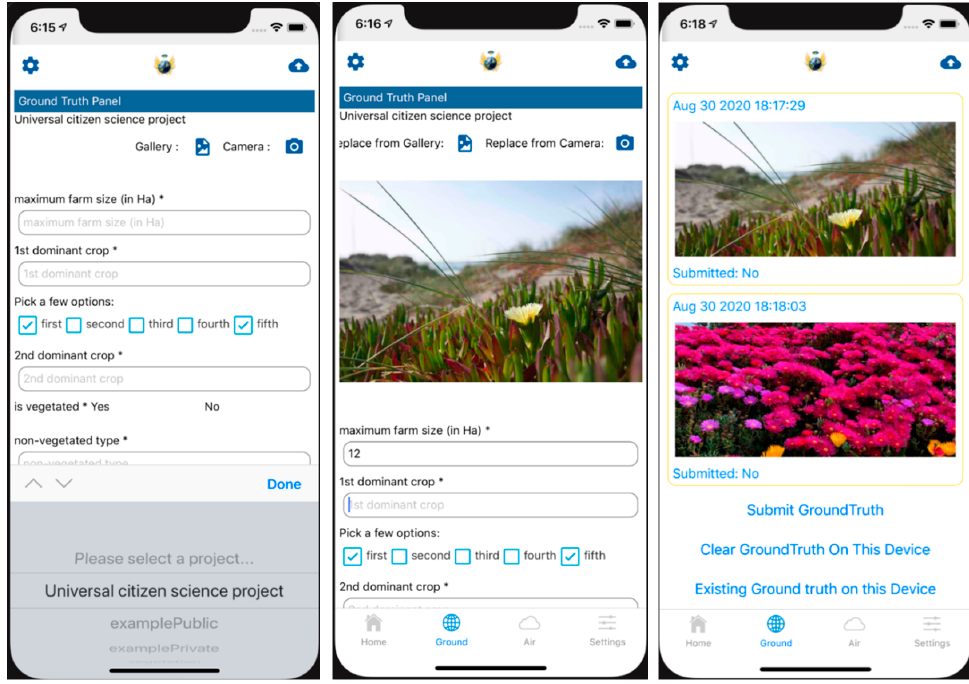
Figure 6. Flexible Citizen Science Module Demonstration.